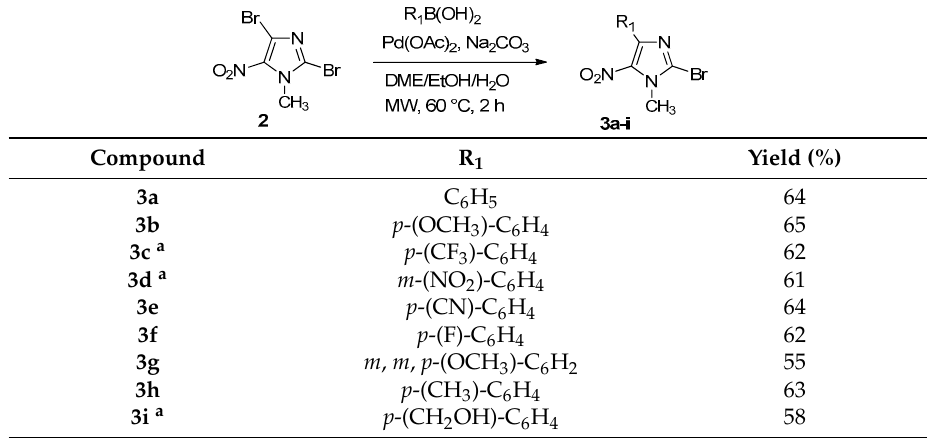
Table 2. Scope of the regioselective Suzuki-Miyaura reaction.